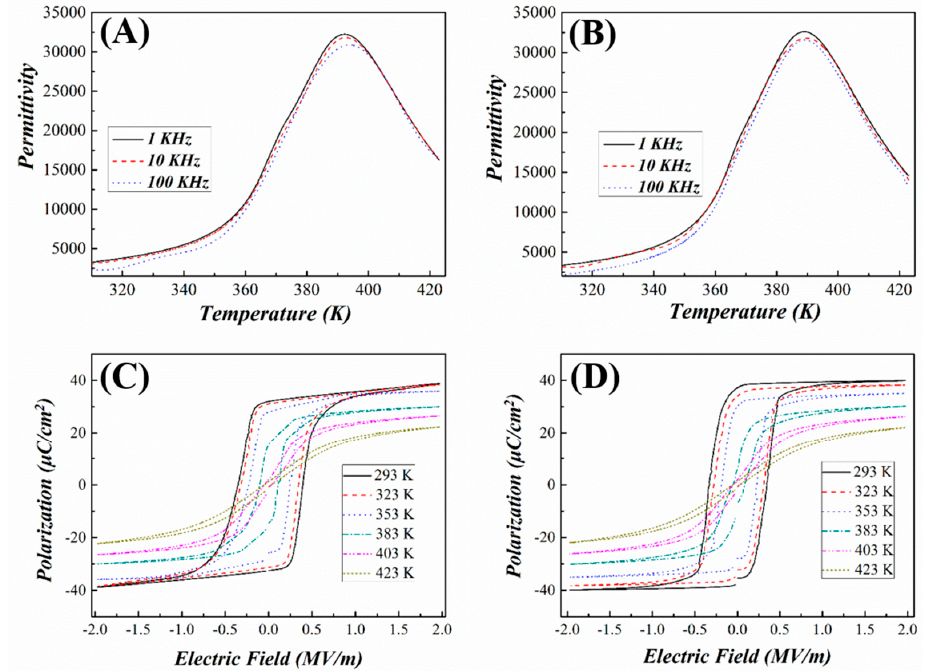
Figure 2. Permittivity and polarization–electric fields (P–E) hysteresis loop as a function of temperature for PMN-PT single crystals with the [110] direction ( A , C ) and [111] direction ( B , D ). At low temperatures, the shape of the loops is rather square due to the absence of grain boundaries in single crystals [18]. With the increasing temperature, the hysteresis loops for the two samples exhibit a transition from square loops to slim ones. At each temperature, the remnant polarization ( 𝑃 (cid:3045) ) and spontaneous polarization ( 𝑃 (cid:3046) ) along the [110] direction are smaller than that of the [111] direction, but the coercive field ( 𝐸 (cid:3030) ) of [110] direction is slightly larger. There are eight equivalent polarization orientations along the [111] direction for rhombohedral relaxor ferroelectric